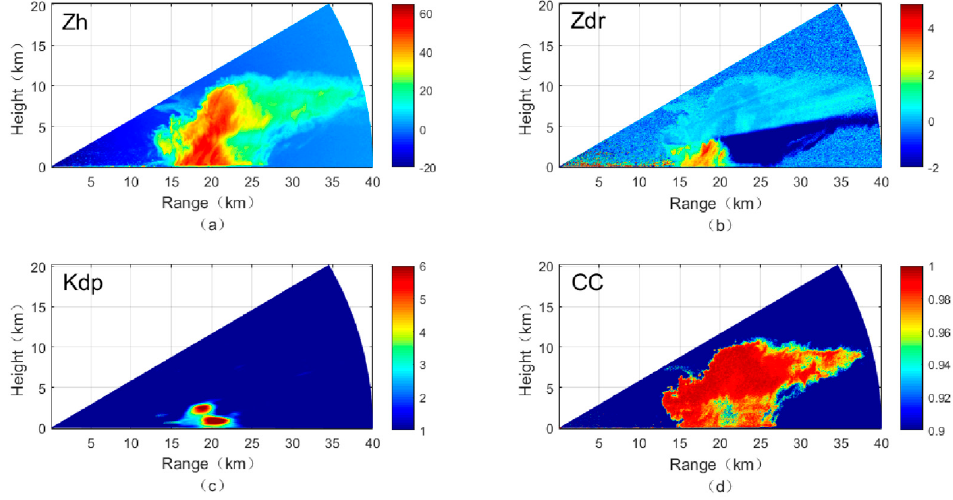
Figure 7. RHI scans of dual-polarization variables of ( a ) Z h ; ( b ) Z dr ; ( c ) K dp ; and ( d ) CC at the azimuth of 37° at 20:32 UT on 30 July 2017.